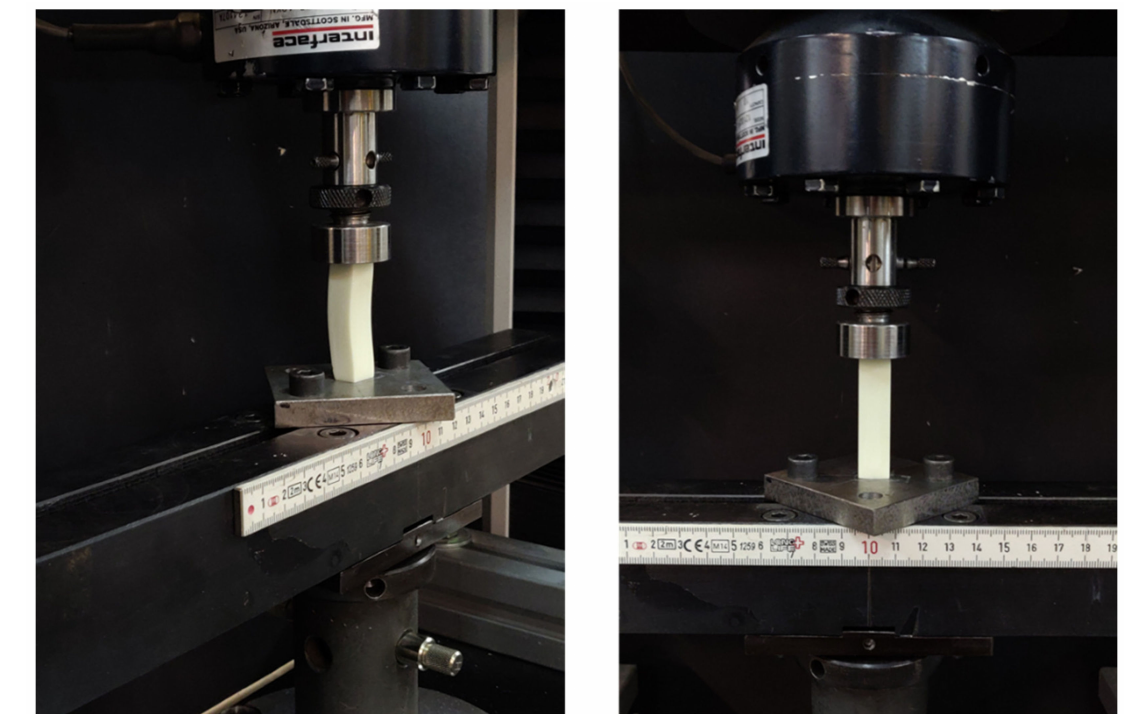
Figure 3. Experimental test set-up for reinforced compression specimens (12.7 × 12.7 × 50.4